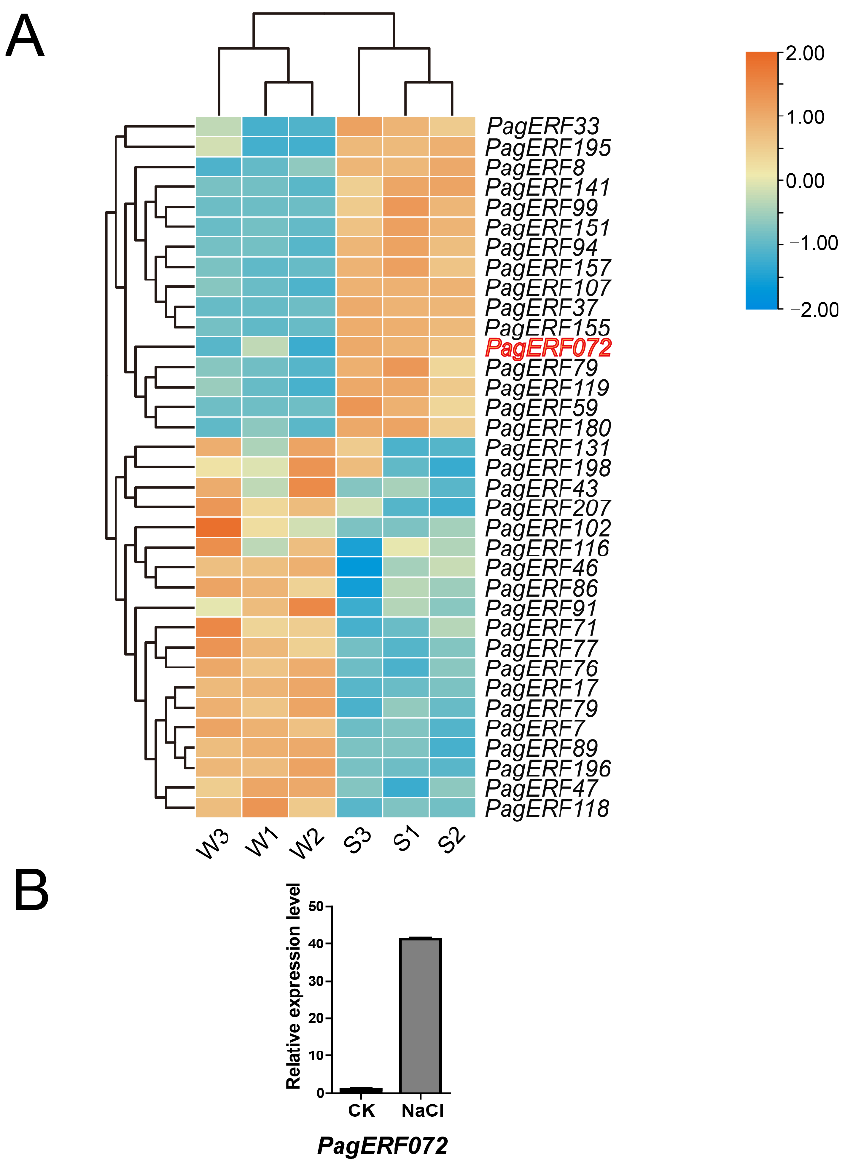
Figure 1. Heatmap of differentially expressed ERF genes after 0 and 150 mM NaCl treatment. ( A ) Orange color represents high expression; blue color represents low expression; W1–3: control condition; S1–3: 150 mM NaCl treatment. ( B ) Gene expression analysis by qRT-PCR. CK and NaCl represent control condition and salt treatment, respectively.